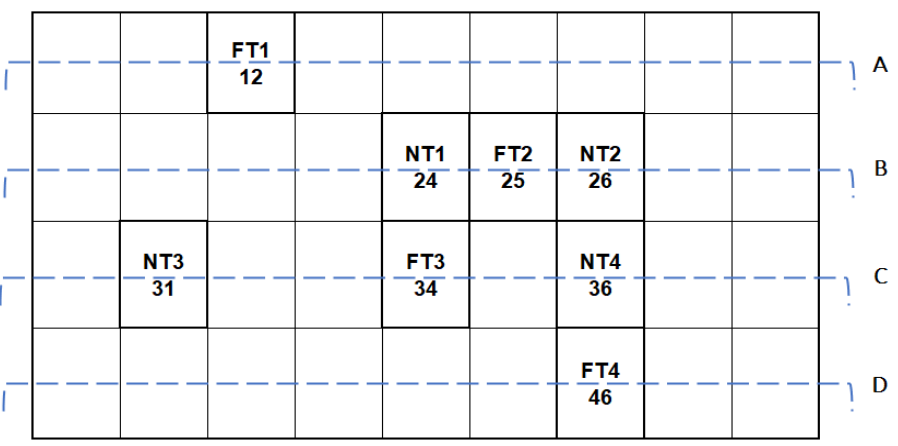
Figure 2. Layout of the field experiment showing the replicates for the FAO (FT) and NDVI (NT) replicates (1–4) under study. Plots are 11.2 m (horizontal directions) × 18.5 m (vertical direction). A, B, C, and D represent transects in Figure 3.